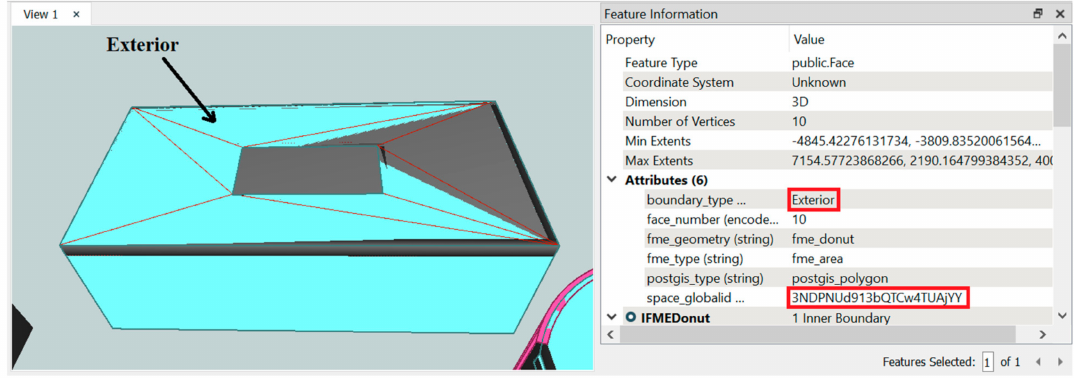
Figure 29. Exterior boundary type associated with roof assigned to the face of legal space with a hole.